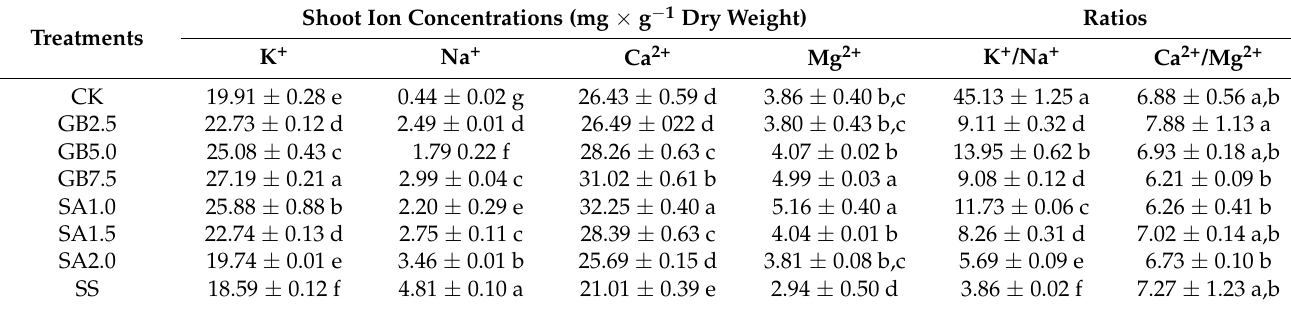
Table 1. Effect of exogenous glycine betaine (GB) and salicylic acid (SA) on shoot ion concentrations under the 150 mM NaCl